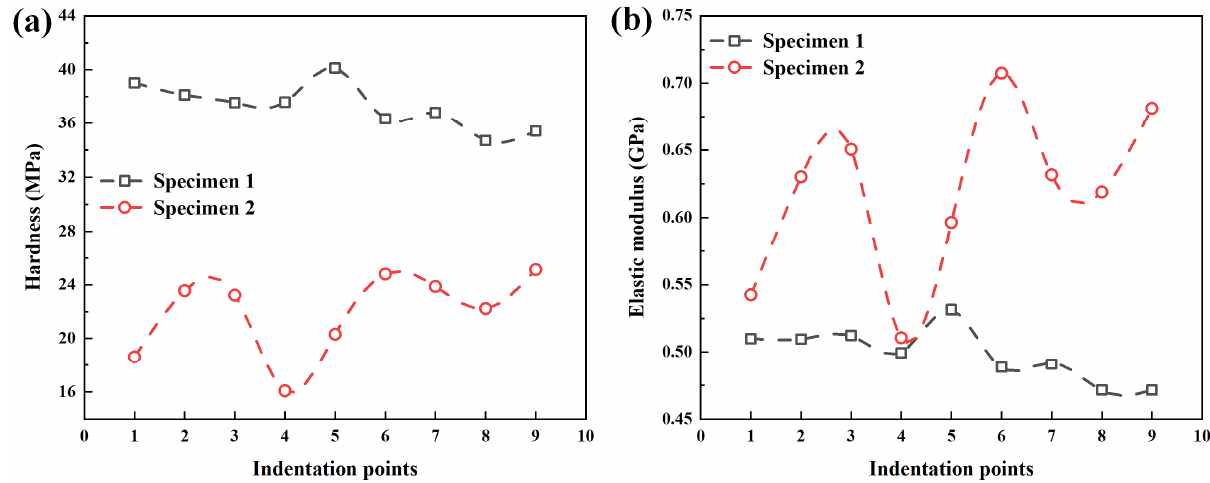
Figure 8. Mechanical parameters of specimens based on the fitting curve method: ( a ) hardness; ( b ) elastic modulus.